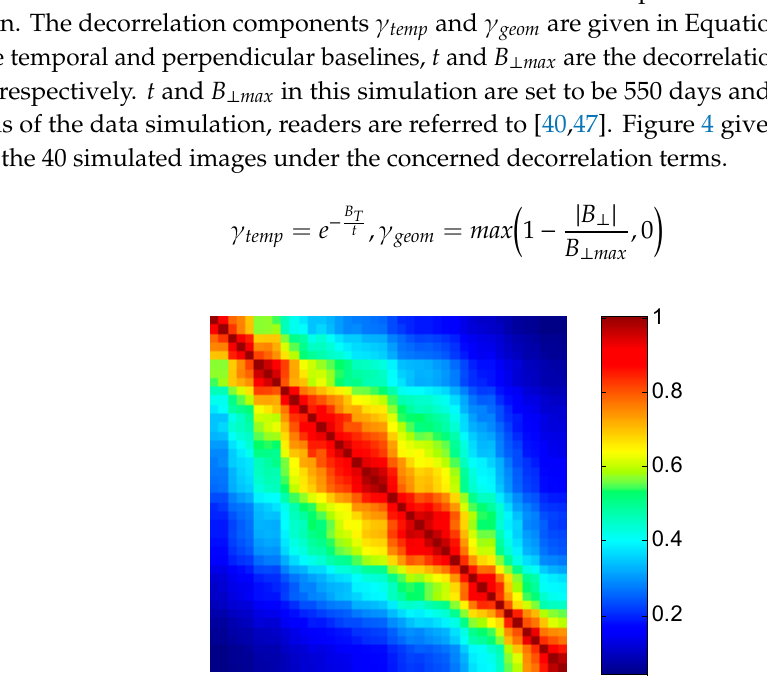
Figure 4. Coherence matrix of the simulated SLCs, with image number N = 40.